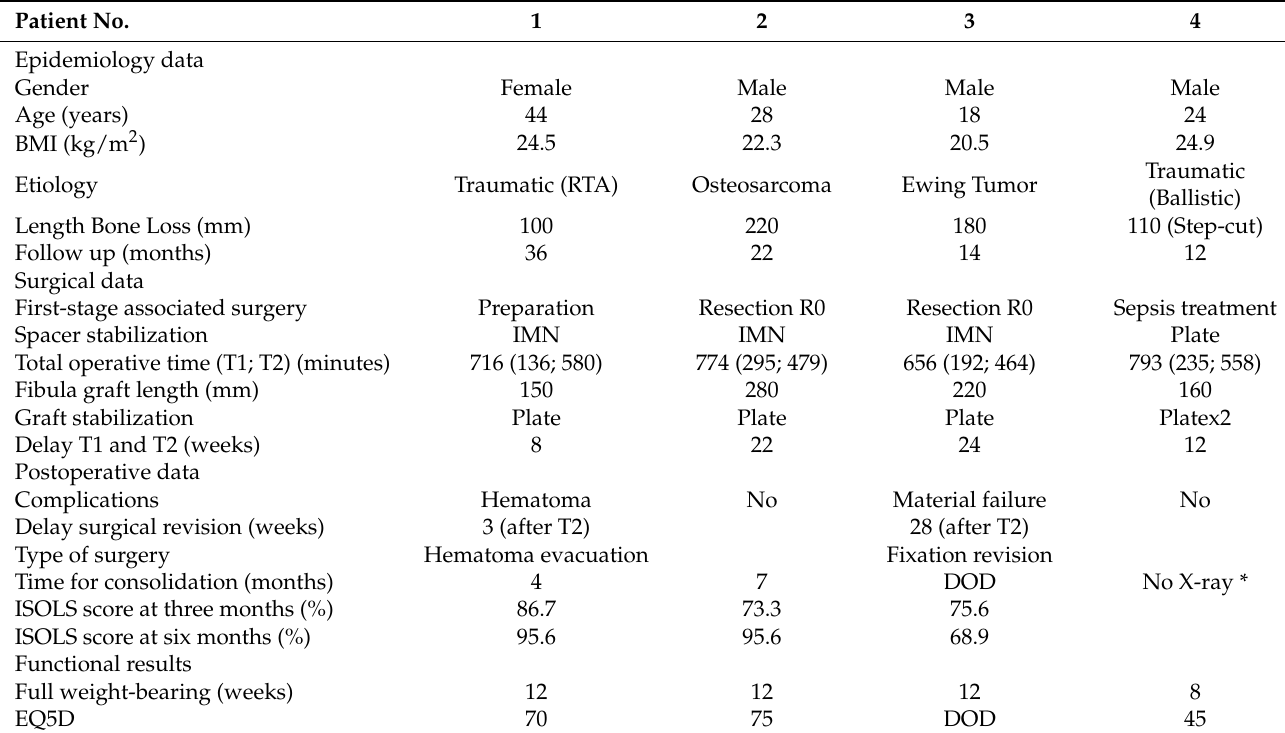
Table 1. Summarized data for the four patients operated on using the Capasquelet technique. IMN: Intramedullary nail, T1: first stage, T2: second stage, RTA: road traffic accident, DOD: dead of disease, * Patient refused radiological follow up, with only clinical follow